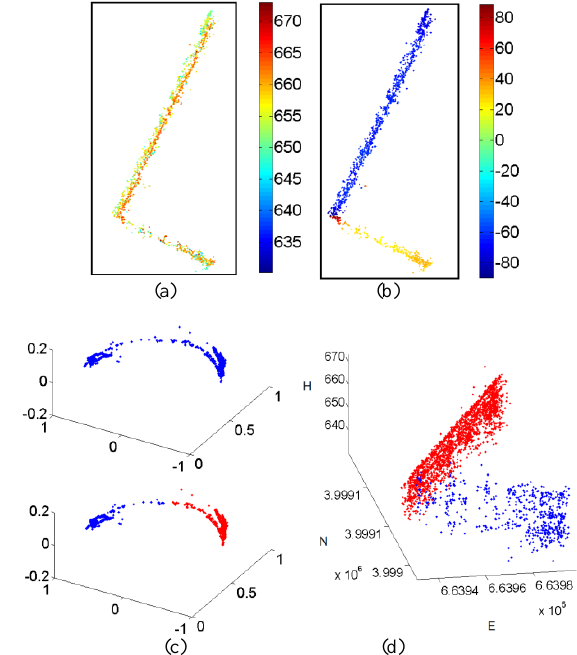
(d) Figure 4 : Fine clustering results after applying mean shift clustering to spatially connected clusters: (a) TomoSAR points of one particular density connected cluster (top view). Colorbar indicates height in meters; (b) Corresponding orientation angle in degrees; (c) Non clustered (top) and clustered (bottom) points in the Gaussian image of points in (a); (d) Resulting clustered points in 3D.